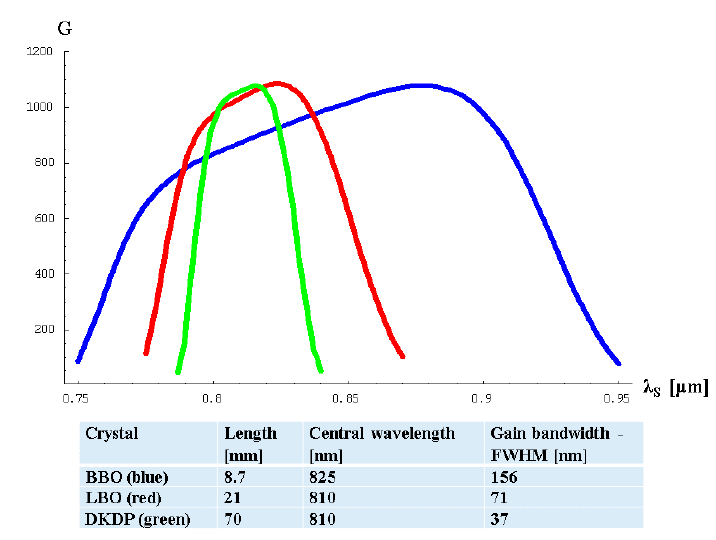
Figure 17. Gain bandwidth of nonlinear crystals in the range of 800 nm .